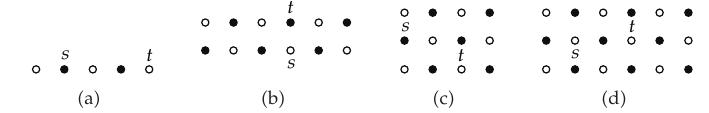
Figure 2: Rectangular grid graphs in which there is no Hamiltonian path between s and t